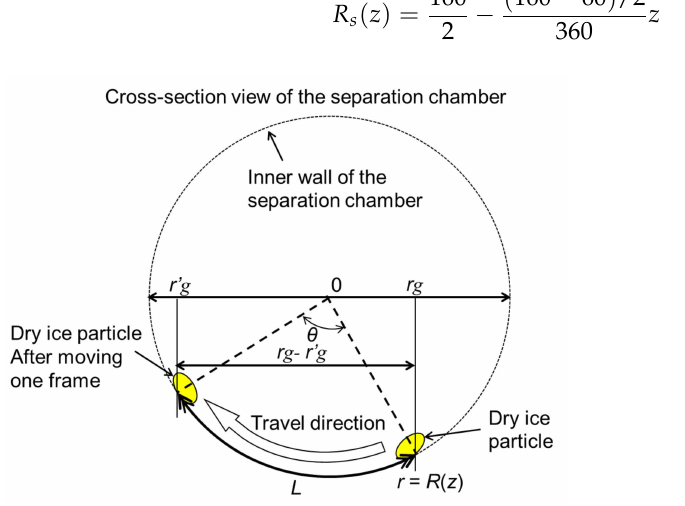
Figure 4. Diagram of the circumferential distance correction of the dry ice particles between